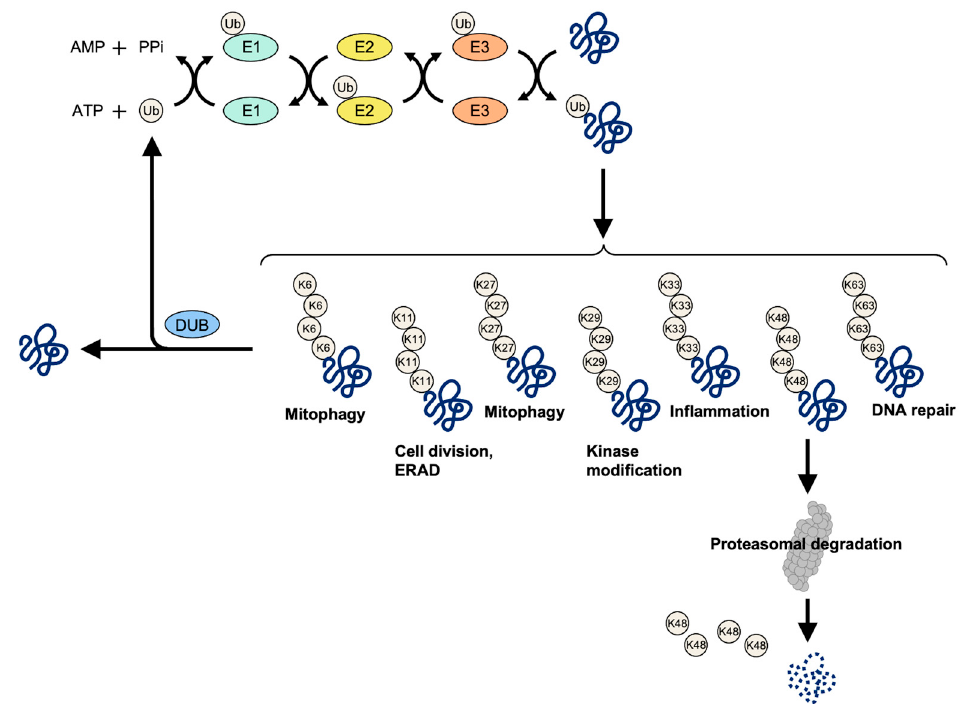
Figure 1. Schematic of key events in ubiquitination and deubiquitination. Under the conditions where ATP provides energy, ubiquitin binds to the target protein through the cascade catalytic reaction of ubiquitin-activating enzyme (E1), ubiquitin-conjugating enzyme (E2), and ubiquitin ligase (E3). The ubiquitinated target protein is recognized and degraded by 26S proteasome. At present, 2 E1s, about 50 E2s, and more than 600 E3s are known to be encoded by the human genome. Deubiquitinating enzymes (DUBs) maintain ubiquitin system homeostasis by cleaving polyubiquitin chains or completely removing ubiquitin chains from ubiquitinated proteins. Via deubiquitination, free ubiquitins are generated and recycled.